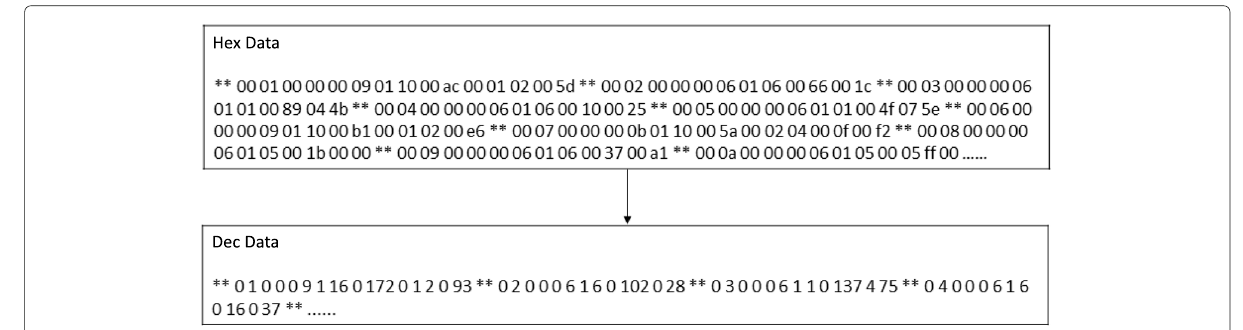
Fig. 3 The conversion process. Conversion of data from HEX to DEC for LSTM